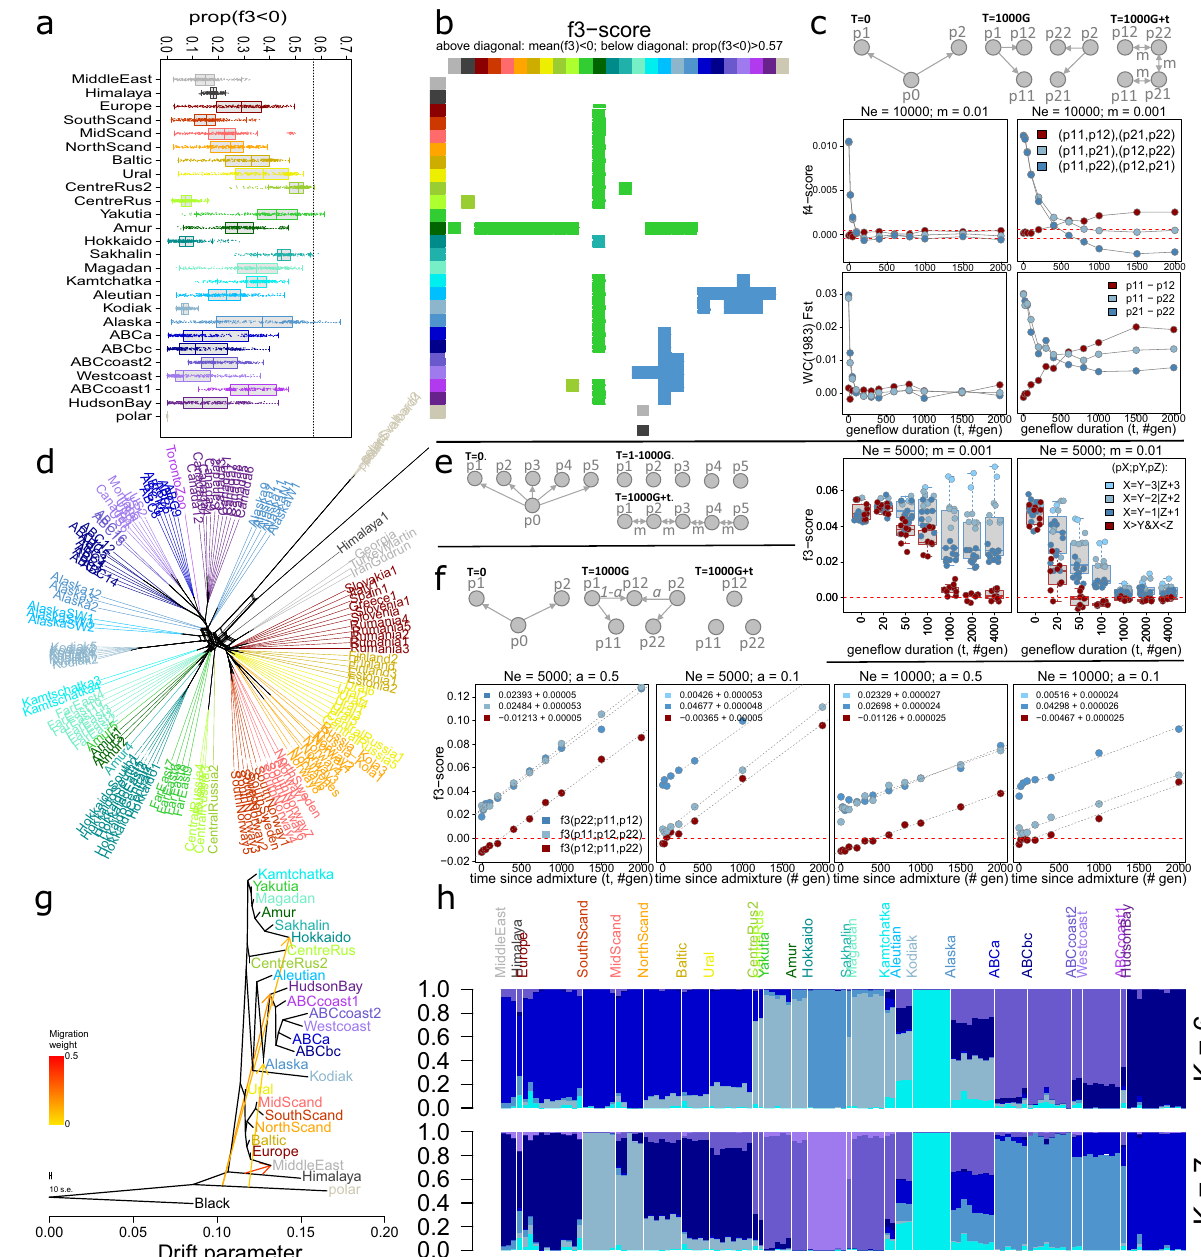
Fig. 4 Admixture analyses suggest hybridisation zones in Alaska and eastern Siberia ( ‘ Yakutia ’ ). a Boxplots with overlaying stripcharts, depicting for all 7800 population triplets (A;B,C) the proportion of 50Kb windows with a f3-score below zero, with the putatively admixed population A along the y -axis. The dashed line denotes an arbitrary cut-off at 0.57. b Matrix highlighting population triplets with negative genome-wide f3-score (above diagonal) or high proportions (>0.57) of 50Kb windows with a negative f3-score (below diagonal), for all populations triplets (A;B,C). Colours along the x - and y-axes represent donor population B and C, while fi eld colours denote admixed population A (i.e., Yakutia, Alaska, Sakhalin and CentreRus2). c Consistent with expectations, SLIM2 genetic forward-in-time simulations indicate that signals of former population structure (here estimated using f4- and F ST -estimates) are lost in approximately 1/m generations, with m , migration rate, denoting the proportion of individuals that are immigrants. Initially, population p12 clusters with sister population p11, but gene fl ow ultimately causes p12 to cluster with unrelated population p22. d Phylogenetic network constructed with the ‘ Neighbor-Net ’ algorithm, based on genome-wide uncorrected genetic distances. The tiplabels of the outgroup (American black bears) are not shown. Polar bears cluster either with black bears or North American brown bears. Bears from the Middle East cluster either with European bears or Himalayan bears. Southwestern Alaskan ( ‘ Aleutian ’ ) bears cluster either with Alaskan bears or Kodiak bears. e SLIM2 simulations indicate that negative f3-scores can arise as a result of isolation-by-distance. f SLIM2 simulations indicate that, as a result of genetic drift, f3-scores increase every generation with a fi xed value of ¼Ne, causing evidence ofpastpulse admixture eventsto eventually disappear. g Treemixmaximumlikelihood phylogeny withthe fourstrongestadmixture edges.Consistent with MSC-based analyses (Fig. 5A), the admixture edges suggest gene fl ow from Himalayan bears into Syrian bears (Middle East), as well as gene fl ow from polar bears into Hokkaido and North American brown bears. h Stacked barplots, generated with the R package LEA, depicting inferred ancestry coef fi cients assuming 6 or 7 ancestral populations. For each pair of closely related individuals, only one individual was included in the